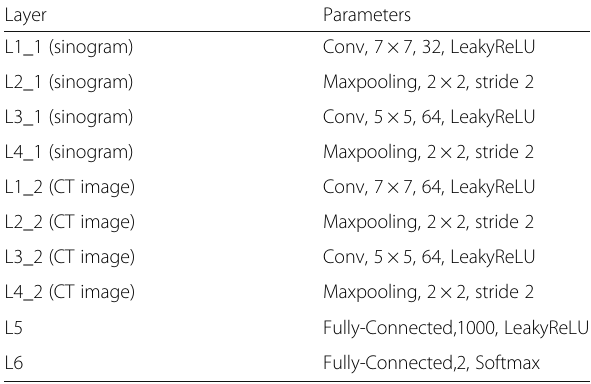
Table 3 Convolutional neural network model settings for combined inputs (sinogram and CT image)